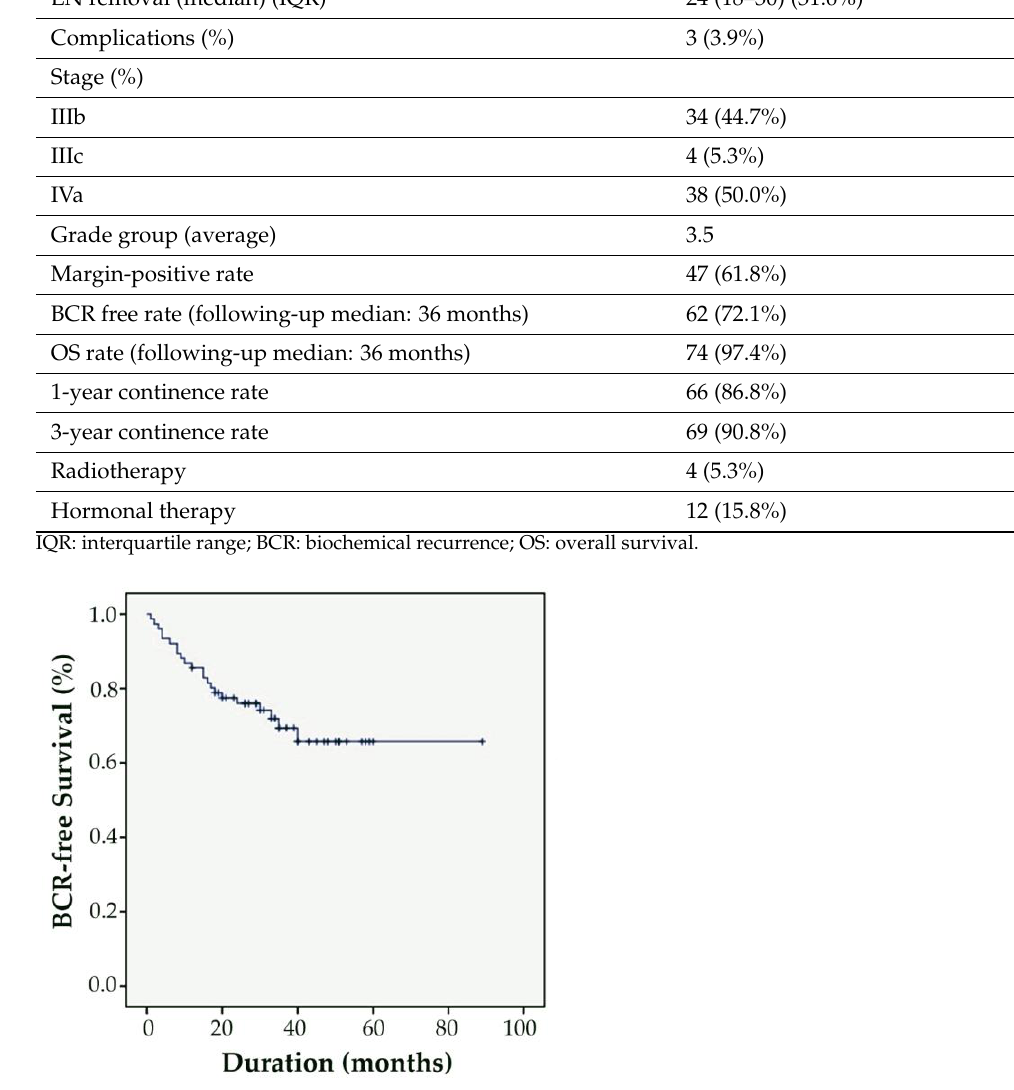
Table 2. Perioperative outcomes for patients with locally advanced prostate cancer.